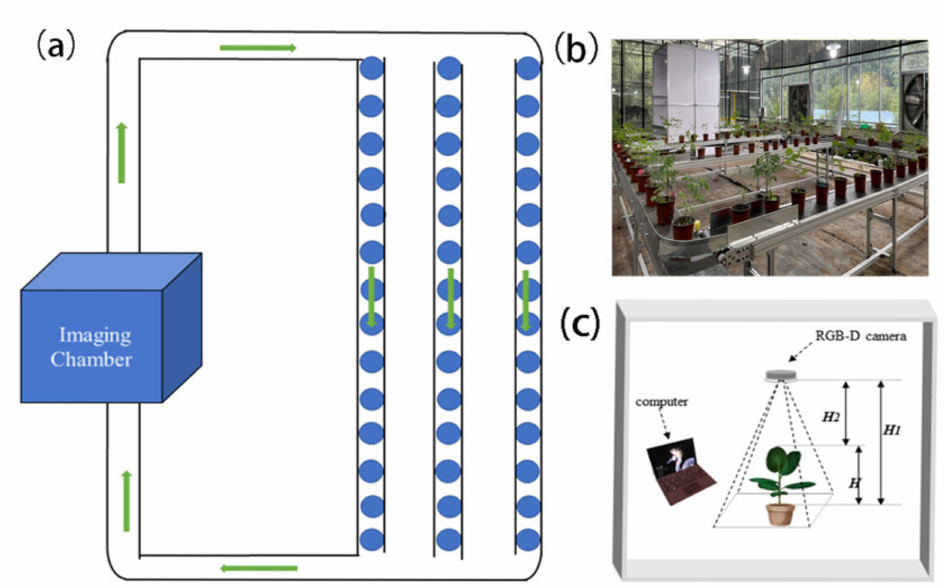
Figure 1. Schematic diagram of the plant phenotyping platform ( a ), including the location of the RGB-D imaging chamber and the position and moving direction of the flowerpot on the conveyor belt. Front view of the imaging chamber ( b ) and schematic diagram ( c